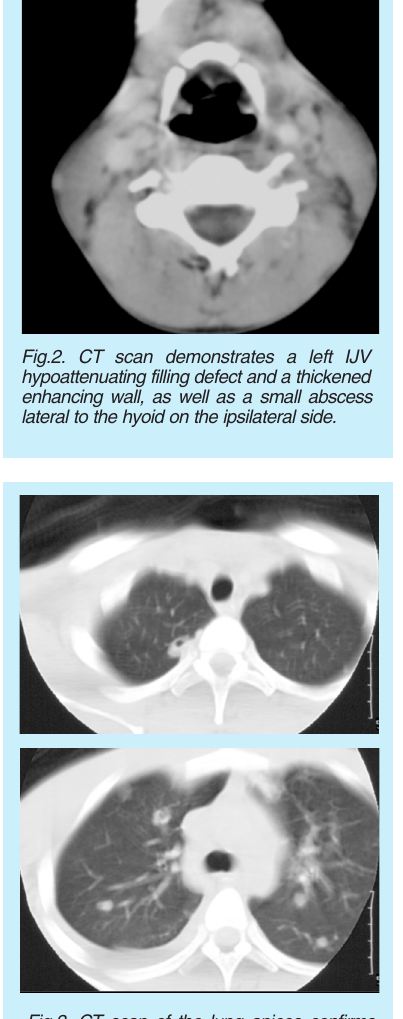
Fig.3. CT scan of the lung apices confirms peripheral cavitating nodules and a right pleural effusion.